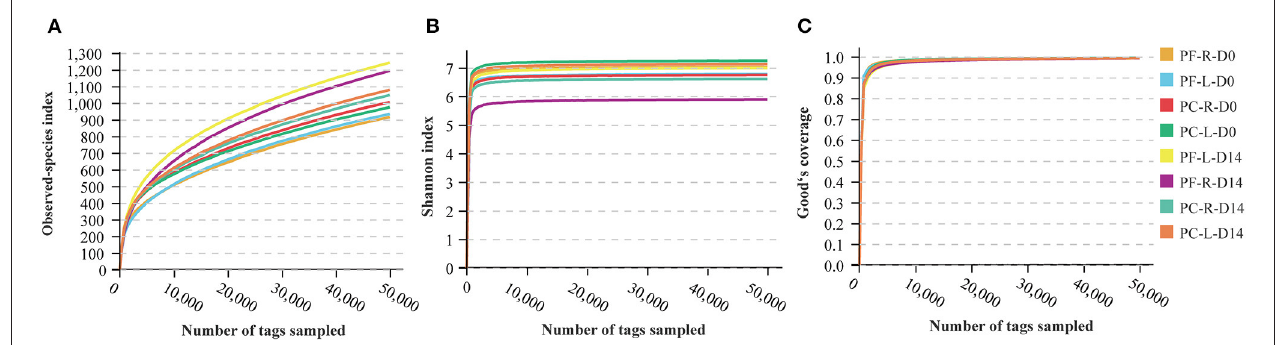
FIGURE 1 | Rarefaction curves computed for alpha diversity indices. (A) Observed-species index for reflection of the observed OTUs of individual sample. (B) Shannon indices for the species richness of samples. (C) Good’s coverage reflected the sequencing saturation of samples. All rarefaction curves of samples from the volunteers reached the saturation platform, indicating that the sequencing data size was reasonable.